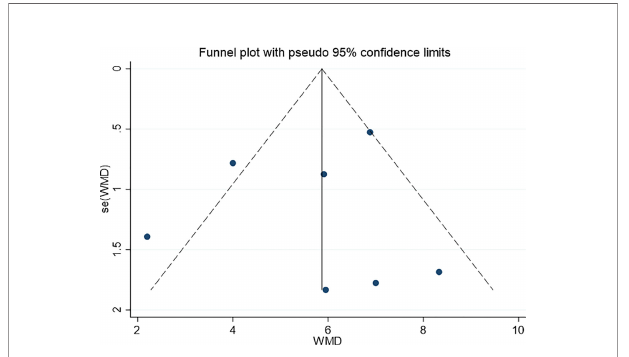
FIGURE 9 | Funnel plot for evaluating the publication bias of this meta-analysis.